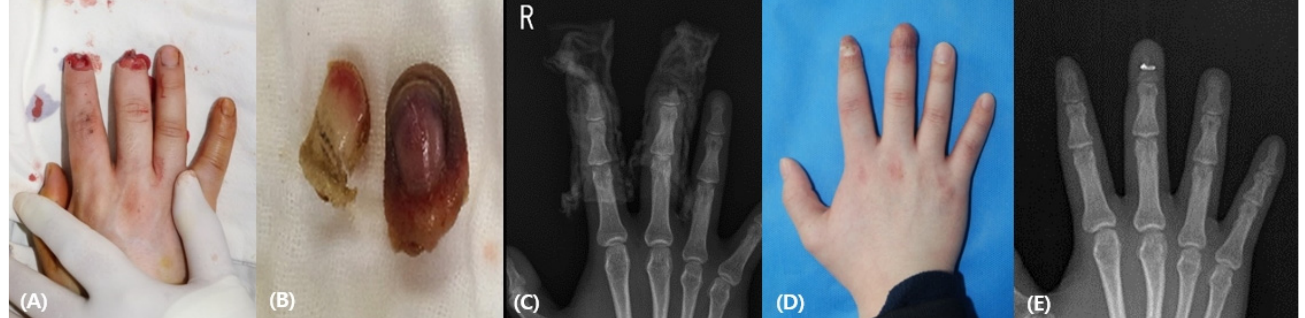
Figure 2. ( A ) A 25-year-old man was injured in his right distal phalanx of the second and